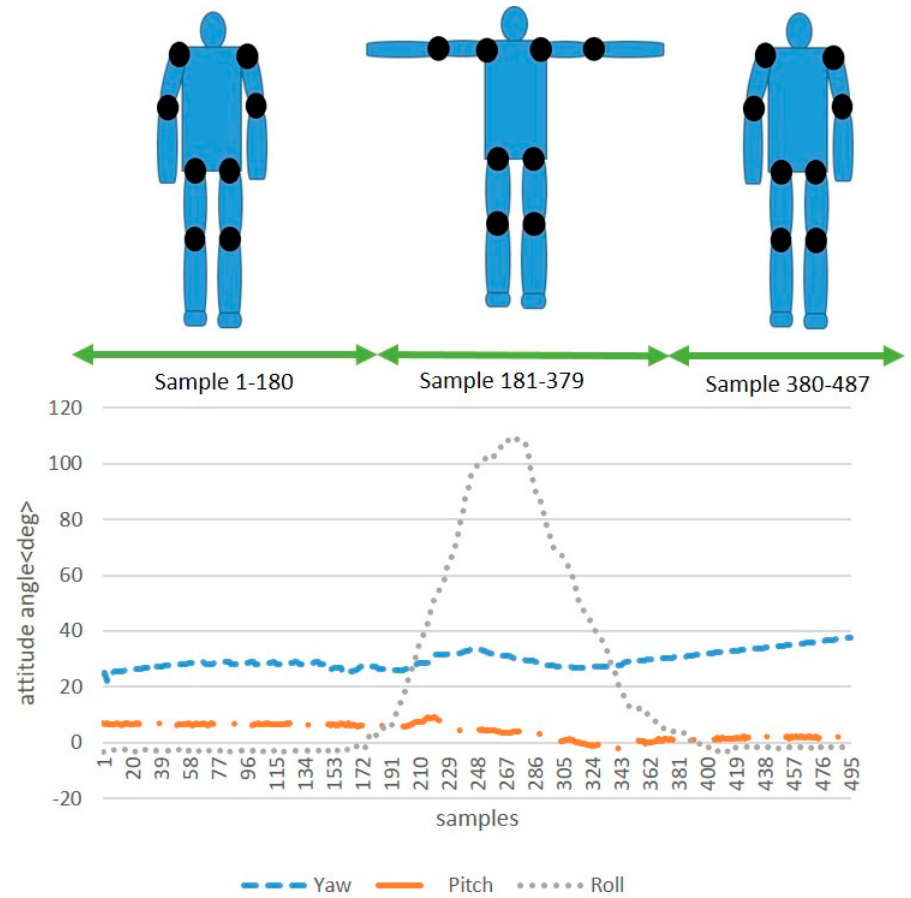
Figure 8. The attitude angles of a sensor node placed on the upper arm when standing in a T-pose.